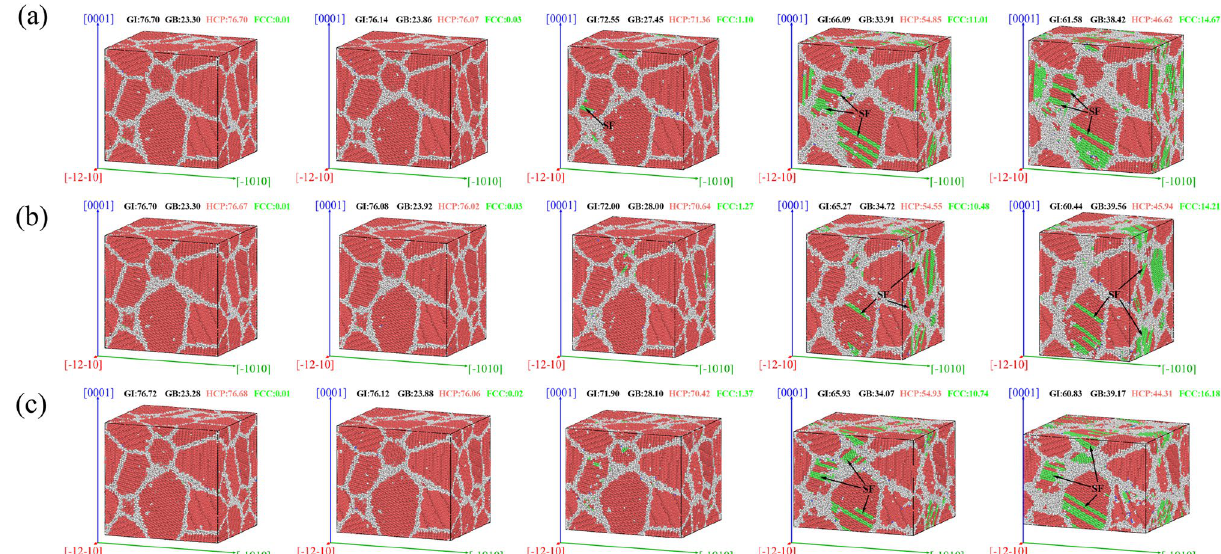
1210 ; ( b ) (cid:31) (cid:30)